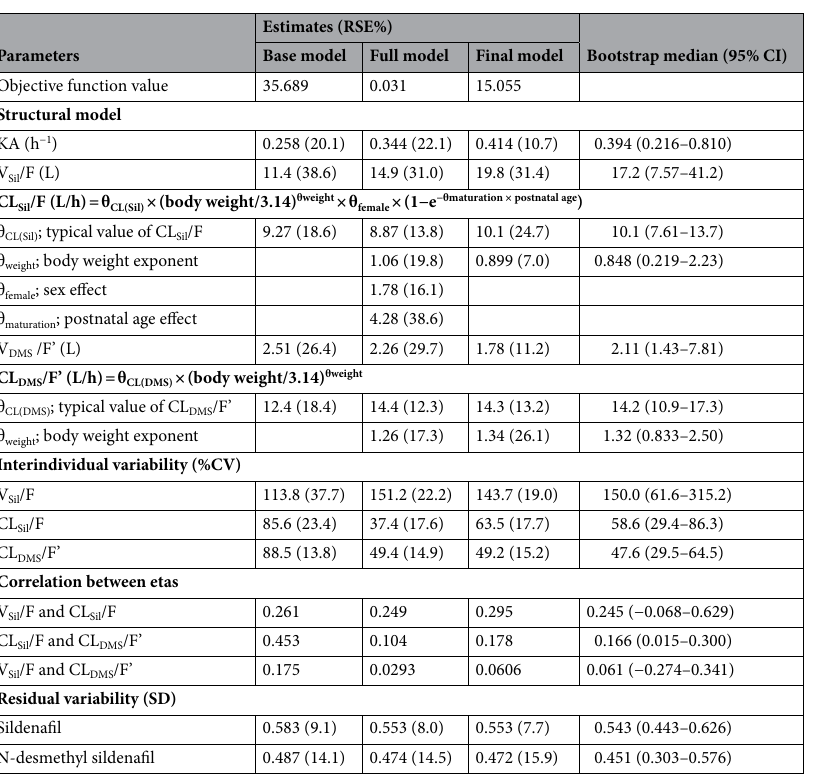
Table 2. Parameter estimates of the final model. KA, absorption rate constant; V Sil /F, apparent volume of distribution of sildenafil; CL Sil /F, apparent clearance of sildenafil; V DMS /F’, apparent volume of distribution of N-desmethyl sildenafil (DMS); CL DMS /F’, apparent clearance of DMS; CV, coefficient of variation; SD, standard deviation; RSE, relativestandard error; CI, confidence